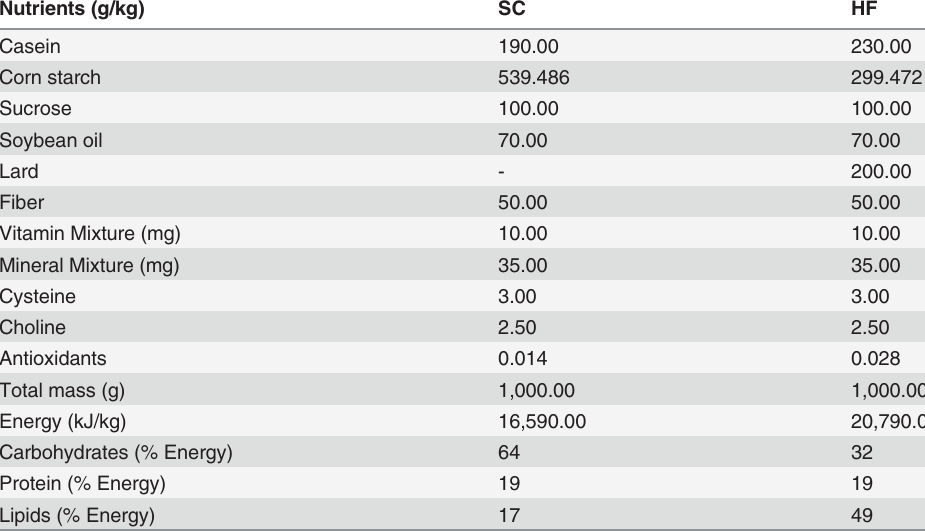
Table 1. Composition and energy content of standard chow (SC) and high-fat (HF) diet (AIN 93G based diets). Nutrients